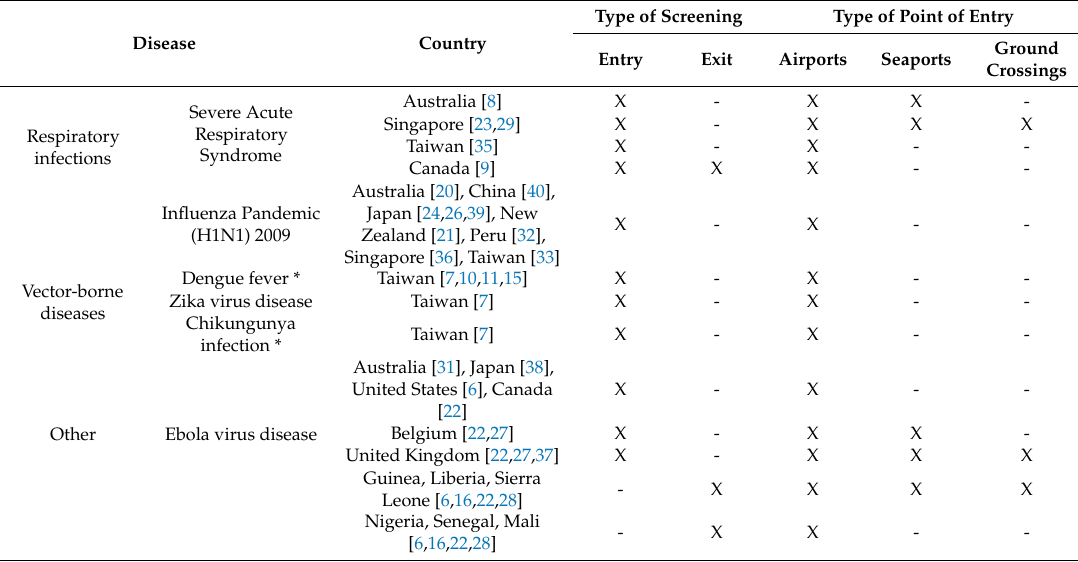
Table 4. Summary results of studies reviewed including type of screening, point of entry (airports, ports, ground crossings), infectious disease targeted, and country of measure